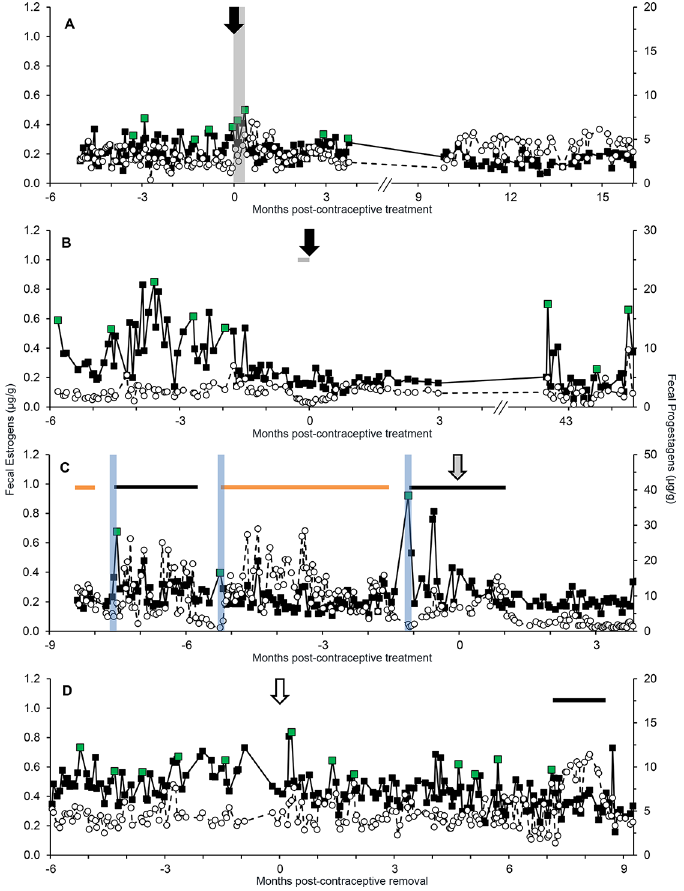
Fig 5. Reproductive steroid hormone profiles ( μ g/g feces, FEM: filled squares, FPM: open circles, dashed line) before and after Suprelorin or MGA treatment and before and after MGA removal. Suprelorin treatment indicated with black arrows in panel A (SB244) and panel B (SB341), MGA treatment represented with a grey arrow in panel C (SB124) and MGA removal denoted with an open arrow in panel D (SB224). Green data points indicate estrous peaks, vertical blue bars correspond with breeding, black horizontal bars represent non-pregnant luteal phases and orange horizontal bars signify pregnancies. In panel A, the vertical grey bar shows a 9 d contraception-induced estrous event. In panel B, the horizontal grey bar denotes a 14 d oral megestrol acetate (MA) treatment prior to Suprelorin placement.